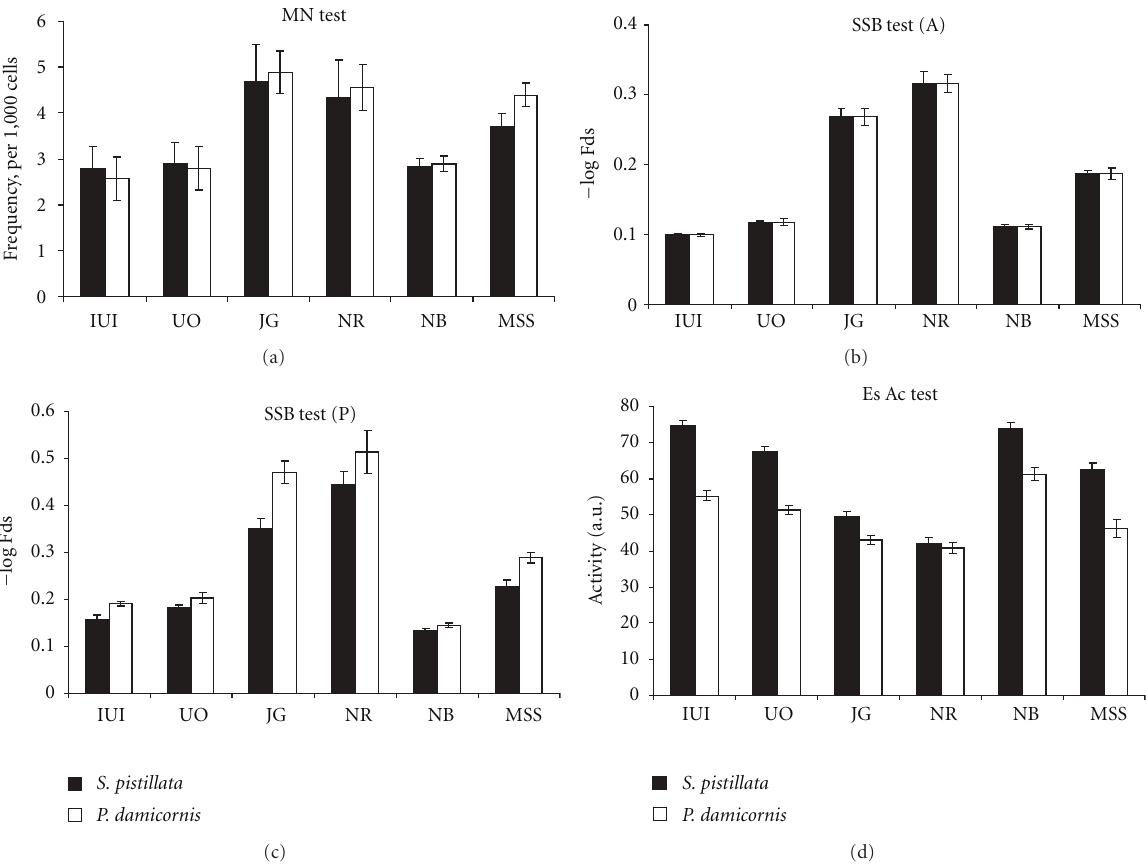
Figure 3: The average results of the four cytological tests on samples of Stylophora pistillata and Pocillopora damicornis collected at six of the natural reef sites along the northern part of the Gulf of Aqaba. (a) Micronucleus test (frequencies of micronuclei-containing cells, ‰), n = 9000 cells per sampling site. (b) Frequencies of single-stranded DNA breaks ( − log Fds), n = 120 cells per sampling site (samples stained with Acridine orange). (c) Frequencies of single-stranded DNA breaks ( − log Fds) determined by micromethod with PicoGreen, n = 9 lysate probes of 3000 ± 120 n cells each per sampling site. (d) Esterase activities (arbitrary units), n = 120 cells per sampling site. Bars show 95% confidence limits. Stations are IUI: Eilat’s marine lab, UO: south of the underwater observatory of Eilat, JG: the Japanese gardens at the south part of Eilat’s marine nature reserve, NR: the north part of Eilat’s marine nature reserve, NB: the north beach of Aqaba, MSS: Aqaba’s marine station.